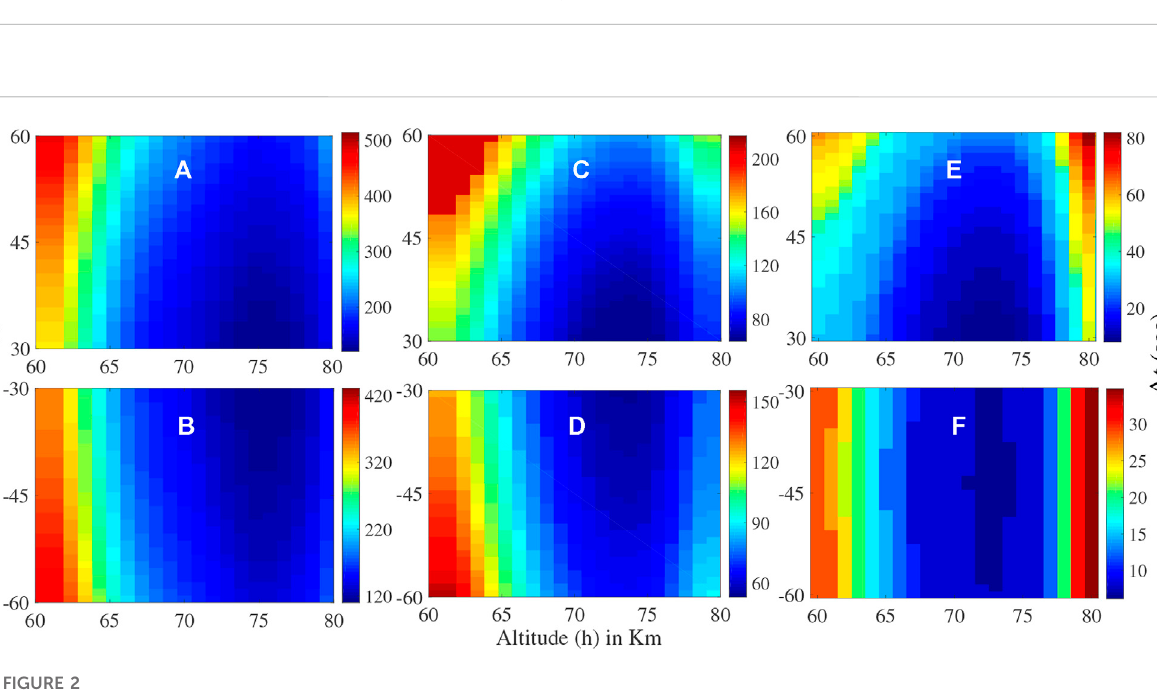
’ s at different altitudes are joined with solid lines. max